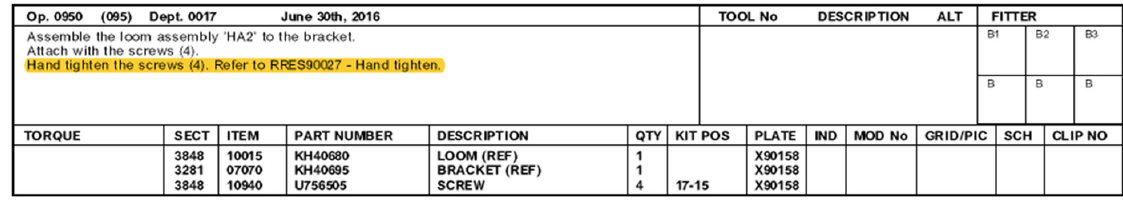
Figure 3. The SOP process confirming temporary tightening.